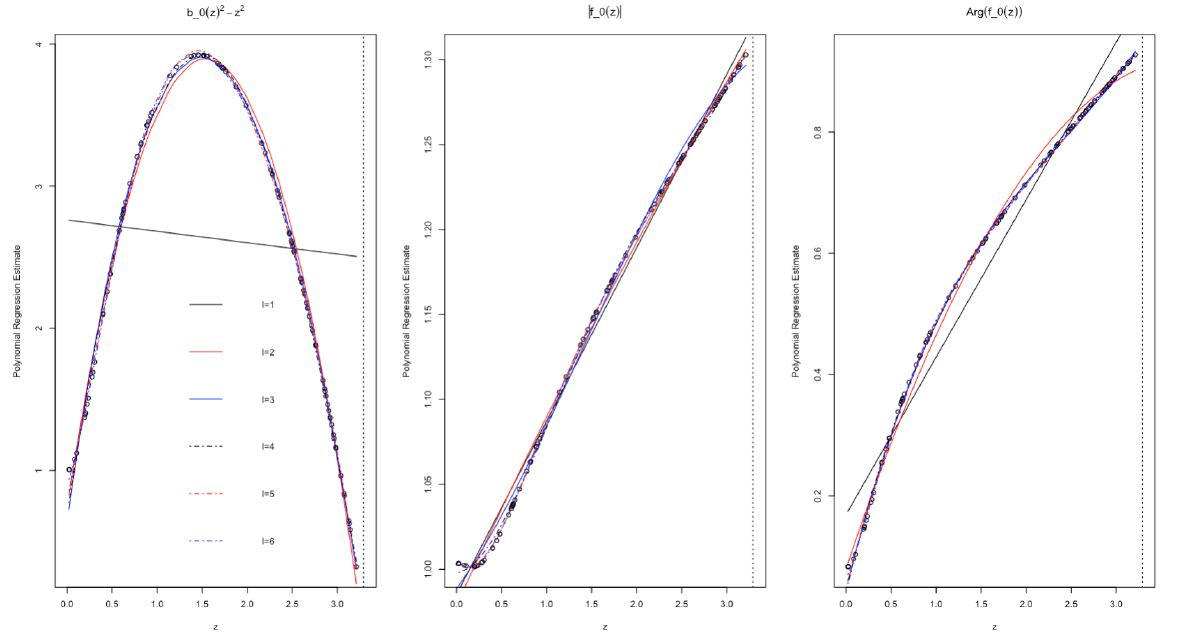
Figure 7. The estimates of critical collapse functions corresponding to a β solution of a hyperbolic case based on a polynomial regression method of orders l = { 1, . . . ,6 } based on a training sample of size n = 100.